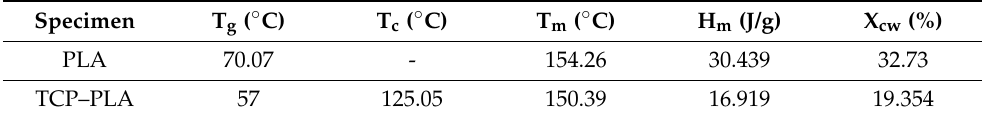
Figure 6. XRD patterns of TCP, PLA, and TCP–PLA. Table 1. Thermal properties of PLA and TCP–PLA filaments obtained from